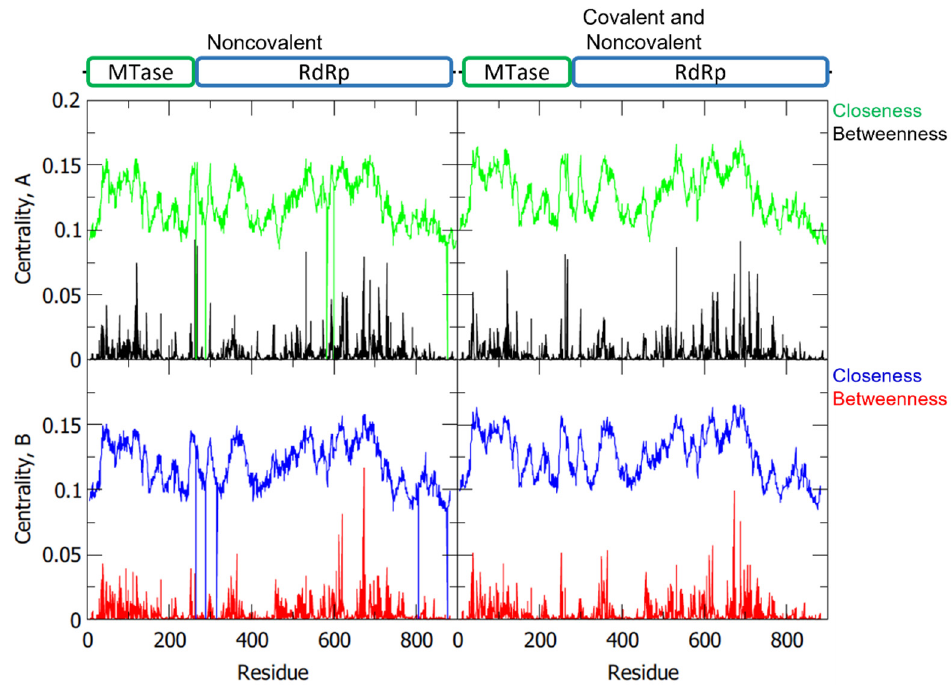
Figure 5. Betweenness and closeness centrality of the NS5 homodimer residues with separate plots for chain A and chain B, and for noncovalent only and covalent with noncovalent interactions.